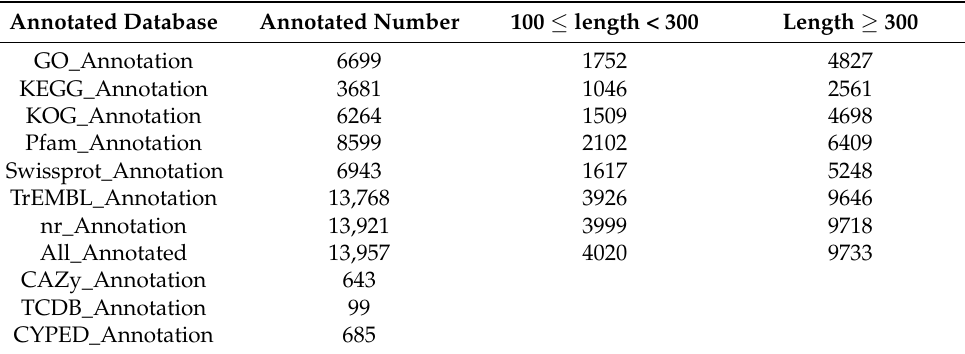
Table 2. Functional annotation of deduced proteins by sequence-similarity